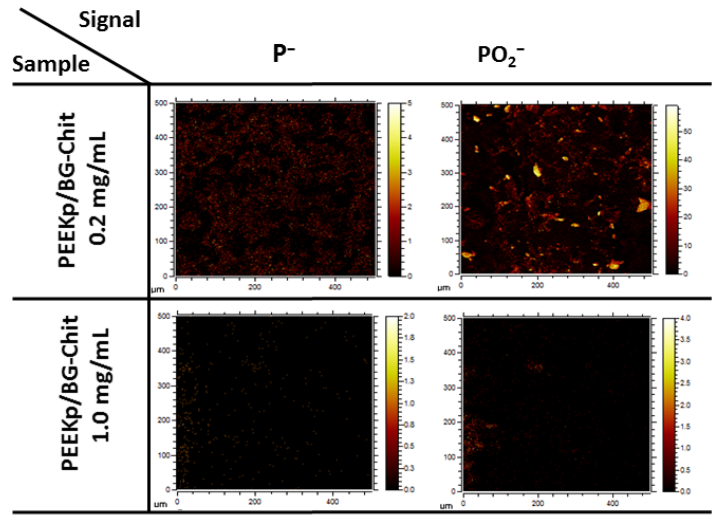
ions for PEEKp/BG-Chit 0.2 2